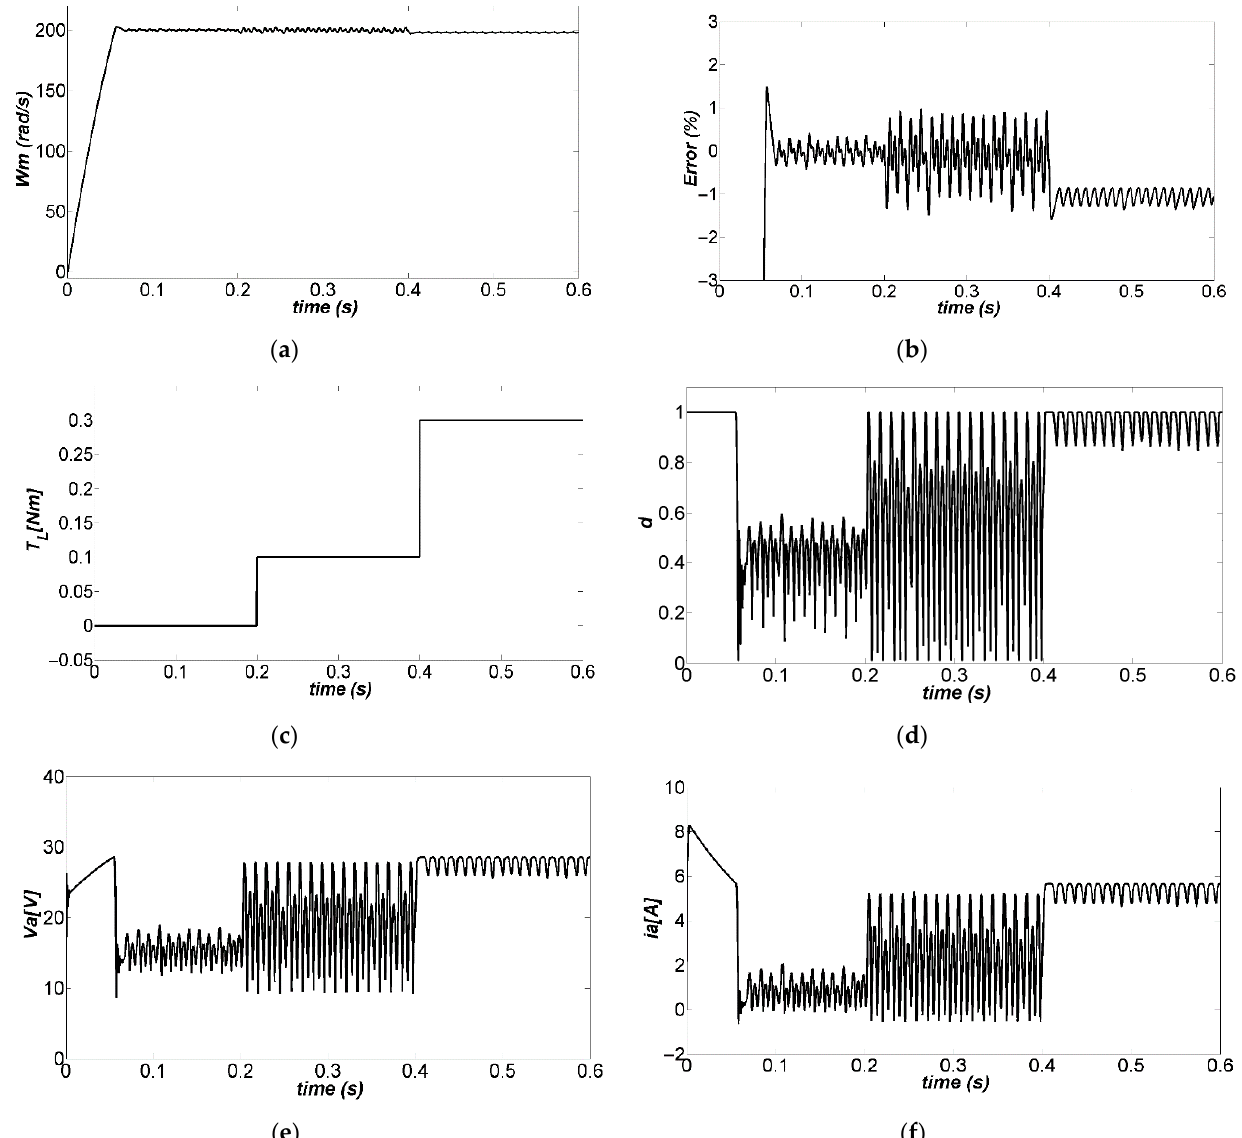
Figure 10. Simulation of the closed-loop system under varying load torque: ( a ) trajectory of the output, ( b ) trajectory of the output tracking error, ( c ) trajectory of the T L , ( d ) trajectory of the d , ( e ) trajectory of the V a , ( f ) trajectory of the i a .